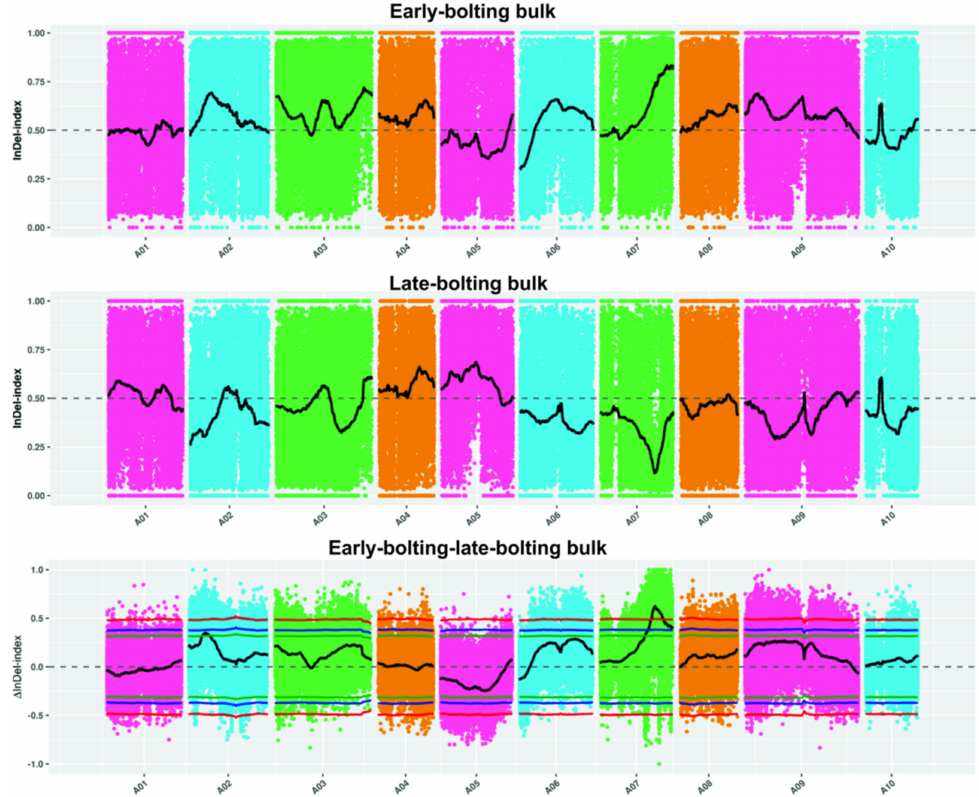
Figure 6. Mapping BrEb-1 by the InDel index method. The abscissa represents the chromosome name; the colored dots represent the calculated InDel index (or ∆ InDel index); the black line indicates the fitted SNP index. The top panel represents the distribution of InDel index values for early-bolting (recessive) bulk; the middle panel indicates the distribution of InDel index values for late-bolting bulk (dominant); the bottom panel represents the distribution of ∆ InDel index values; the threshold line (red) was 0.99; the blue line represents a threshold line with a confidence of 0.95; the green line represents a threshold line with a confidence of